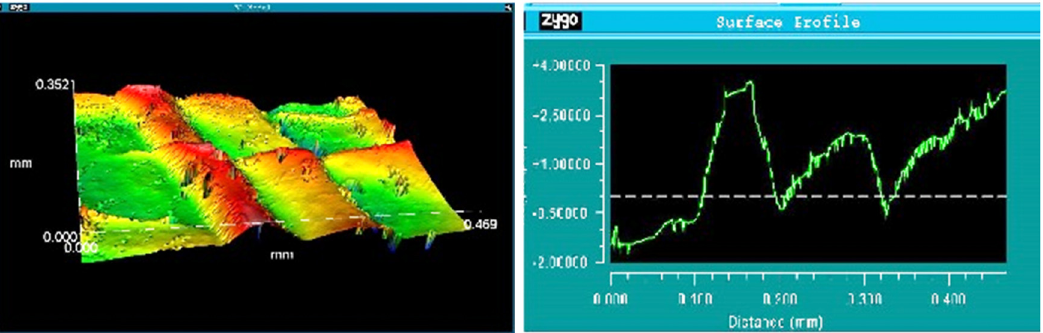
Figure 3: Interferometric image of the proposed collagen membrane, showing 3D bundle fi brils and the roughness surface pro fi le.